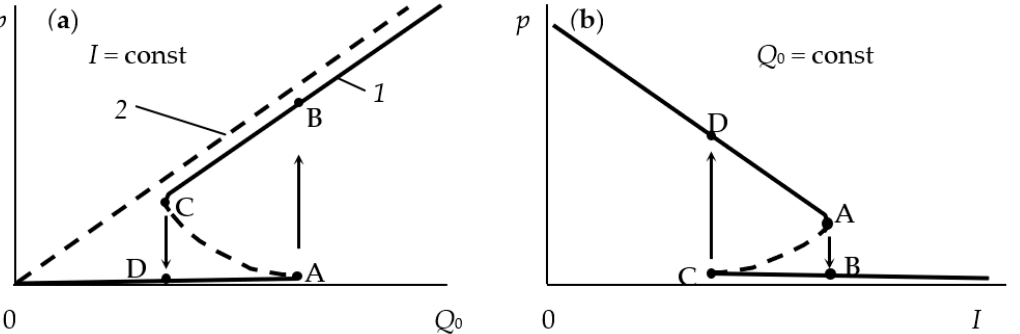
Figure 1. Qualitative view of the dependence of the reactive gas partial pressure during reactive sputtering on: ( a ) — its incoming flow; ( b ) — discharge